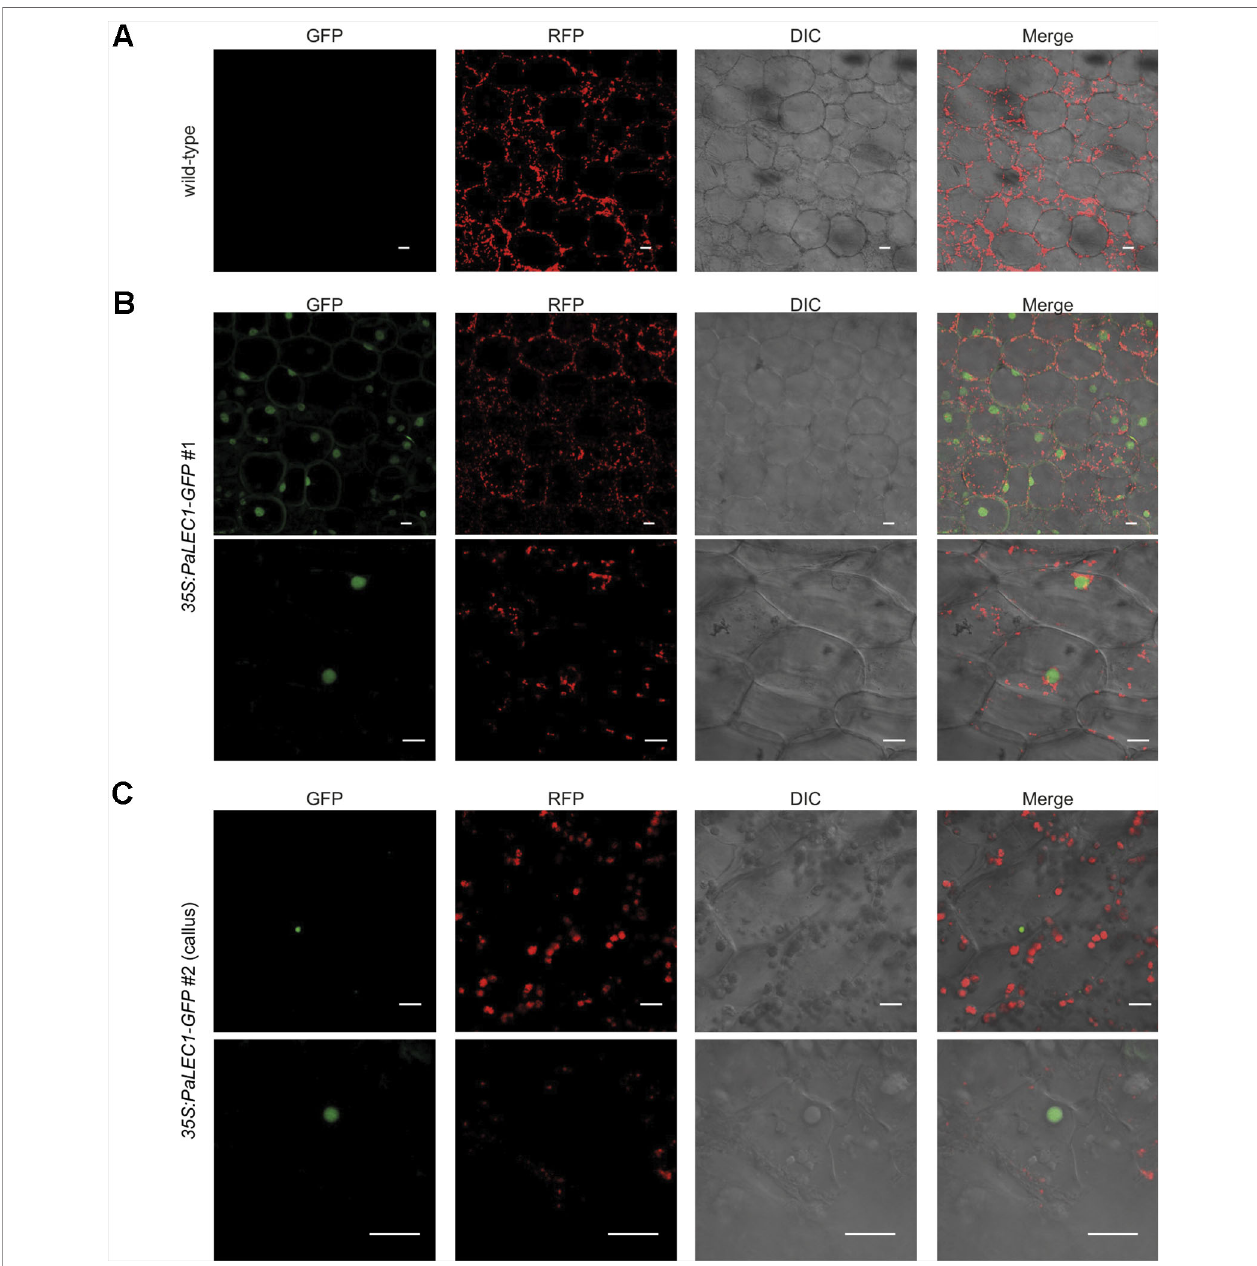
FIGURE 7 | Nuclear localization of PaLEC1-GFP. (A) No GFP signal was detected in wild-type plants. (B) PaLEC1-GFP was detected in nuclei of cells in roots of 35:PaLEC1-GFP#1 transgenic line. Nuclear localization of PaLEC1-GFP was con fi rmed in multiple (more than three) independent seedlings. (C) PaLEC1-GFP was detected in very few nuclei within callus cells of 35:PaLEC1-GFP#2 transgenic line. This sparsely distribution of nuclear PaLEC1-GFP signal was con fi rmed in multiple (more than three) protocorm-derived callus tissues. Photos with lower magni fi cation are shown in the upper panel in panels (B and C) . Photos with higher magni fi cation are shown in the bottom panel in panels (B and C) . GFP, photographs taken in the GFP channel. RFP, photographs taken in the RFP channel. DIC, differential interference contrast images. Merge, differential interference contrast images of cells superimposed with PaLEC1 (GFP) and chloroplast (RFP) channels. Scale bar = 20 m